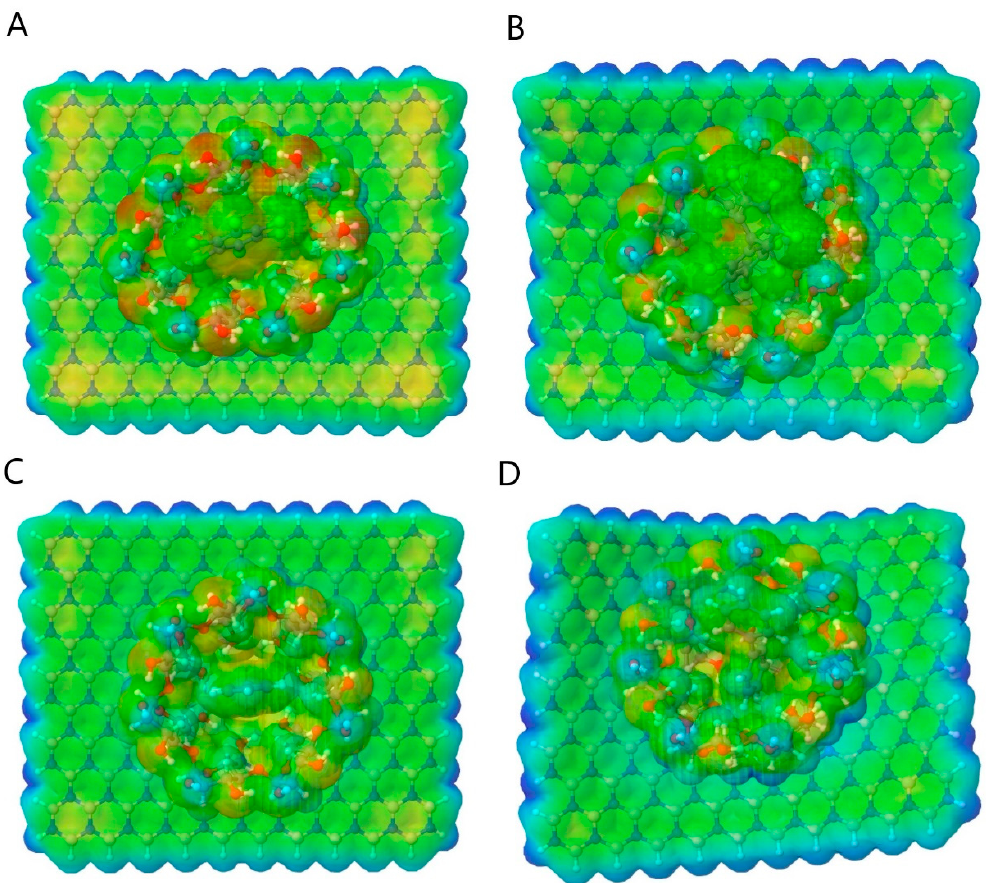
Figure 3. Electrostatic potential of ( A ) hexachlorobenzene (cb), ( B ) decachlorobiphenyl (pcb), ( C ) benzene (b), and ( D ) biphenyl (bp) adsorbed on carbon-doped hexagonal boron nitride (h-BN-CC2) decorated with beta-cyclodextrin (BCD).